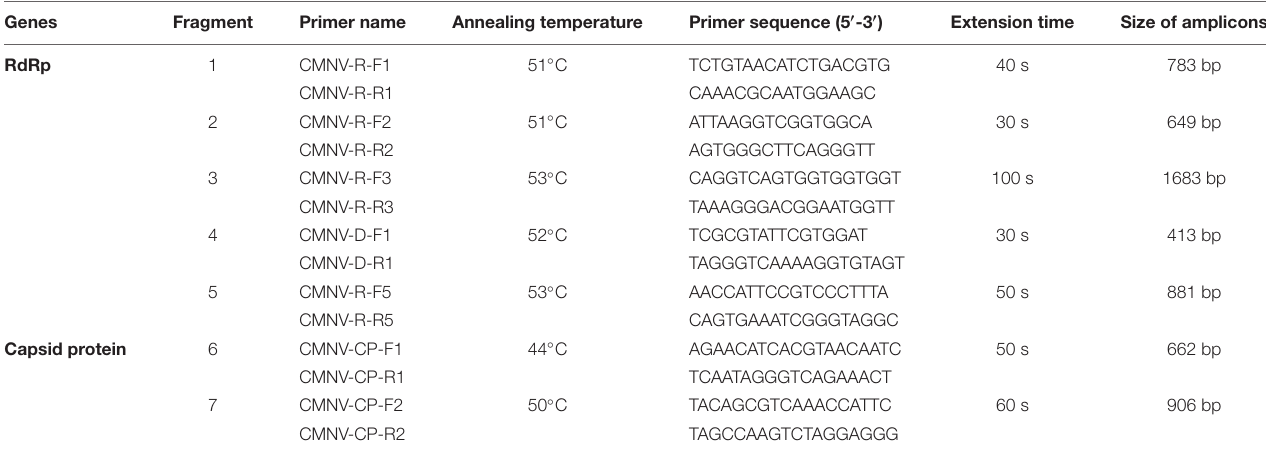
TABLE 1 | PCR primer sequences, annealing temperature, and extension duration used to amplify the RdRp and capsid protein gene sequences of